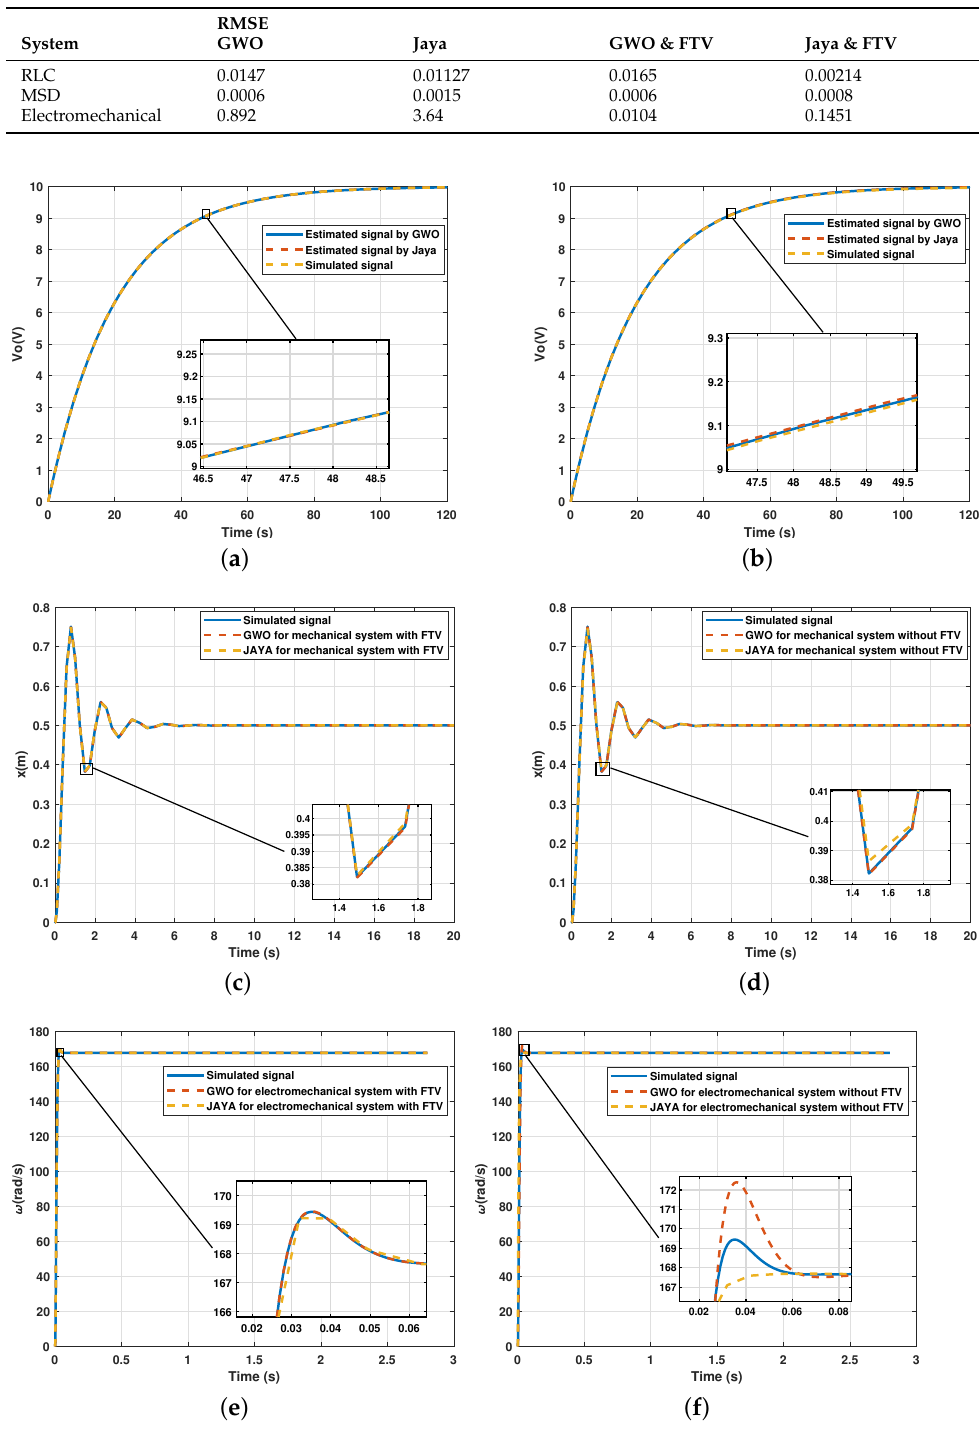
Figure 9. Comparison between estimated signal and simulated signal in second-order systems: ( a ) Algorithms using the FVT as a constraint for the RLC system; ( b ) Unconstrained algorithms for the RLC system; ( c ) Algorithms using the FVT as a constraint for the MSD system; ( d ) Unconstrained algorithms for the MSD system; ( e ) Algorithms using the FVT as a constraint for the DC motor system; ( f ) Unconstrained algorithms for the DC motor